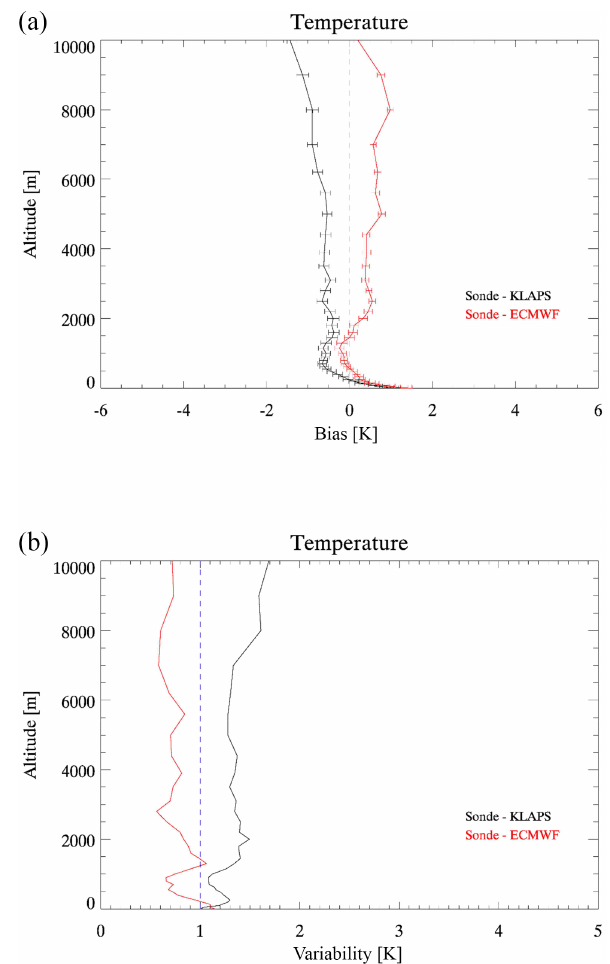
Figure 1. The bias (a) and the variability (b) of the temperature profiles of the NWP data compared to the radiosonde data obtained from June 2012 to July 2013 (total of 117 and 67 data points for KLAPS and ECMWF, respectively). The horizontal error bar in the bias profile represents the standard deviation of mean (red and black solid lines are for the comparison between radiosonde vs. the ECMWF profile and radiosonde vs. the KLAPS data,